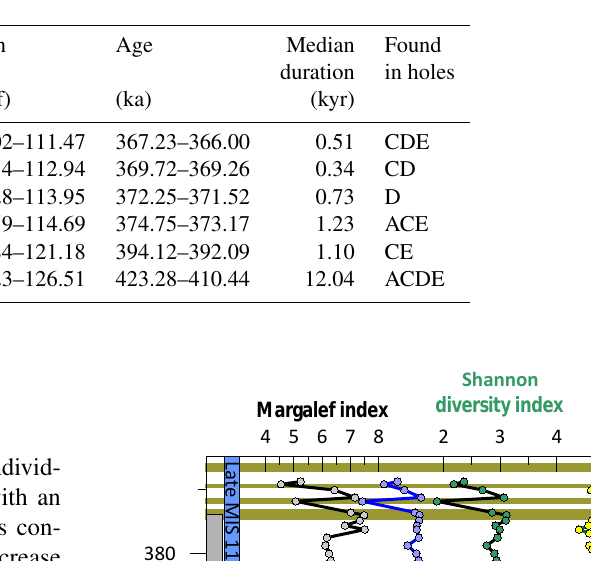
Table 4. Distribution of laminated intervals during MIS 11. Note that the depth and age of laminated intervals encompasses all holes drilled, but the median duration is calculated using each of the holes that it is present in.